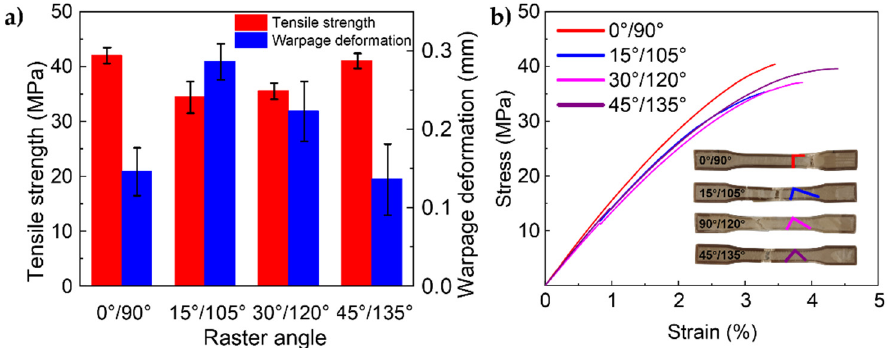
Figure 3. The results of the raster angle optimization. ( a ) tensile strength and warpage deformation; ( b ) stress-strain curve.